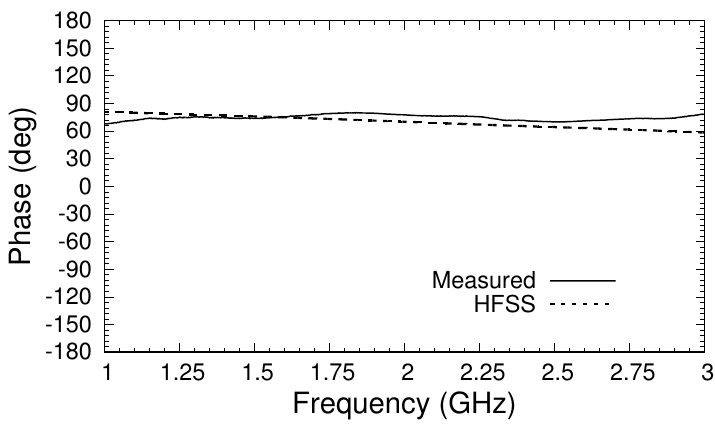
Figure 10. Phase of measured S 21 after calibration for the triaxial system in